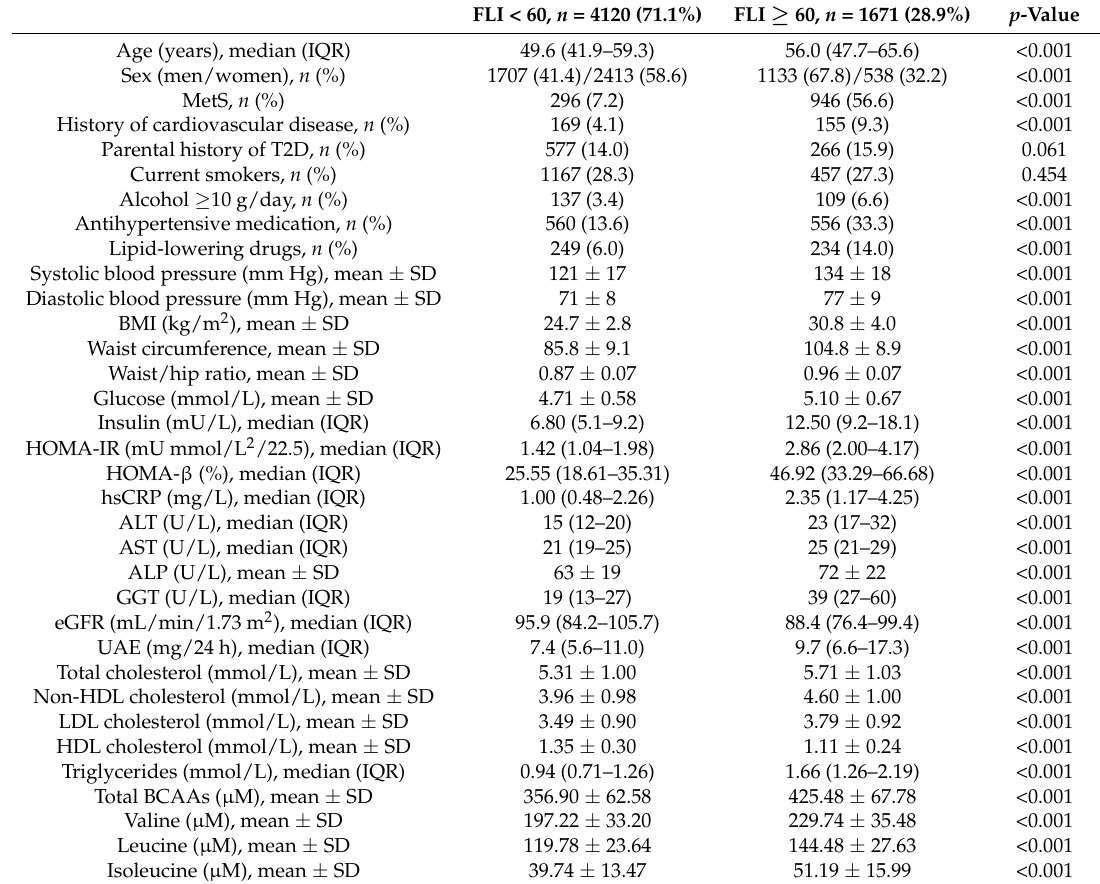
Data are given in number with percentages (%), mean ± standard deviation (SD) for normally distributed data or median with interquartile ranges (IQR) for non-normally distributed data. Abbreviations: ALP, alkaline phosphatase; ALT, aminotransferase; AST, aspartate aminotransferase; BCAA, branched-chain amino acids; BMI, body mass index; FLI, fatty liver index; eGFR, estimated glomerular filtration rate; GGT, gamma-glutamyltransferase; HOMA, Homeostasis Model Assessment; HDL, high-density lipoproteins; hsCRP, high sensitivity C-reactive protein; IR, insulin resistance; LDL, low-density lipoproteins; MetS, metabolic syndrome; T2D, type 2 diabetes; UAE, urinary albumin excretion. LDL cholesterol was calculated by the Friedewald